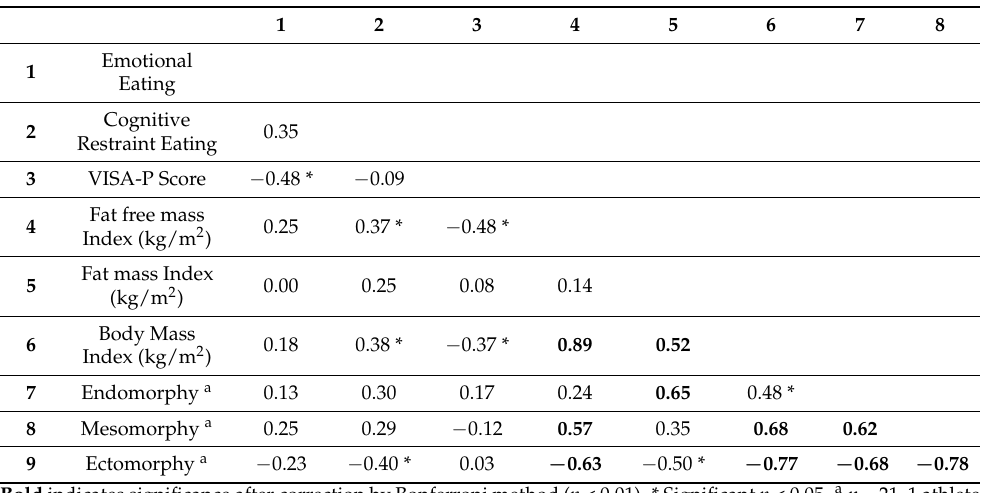
Table 5. Correlation between eating behaviours, knee health, and physique traits ( n =